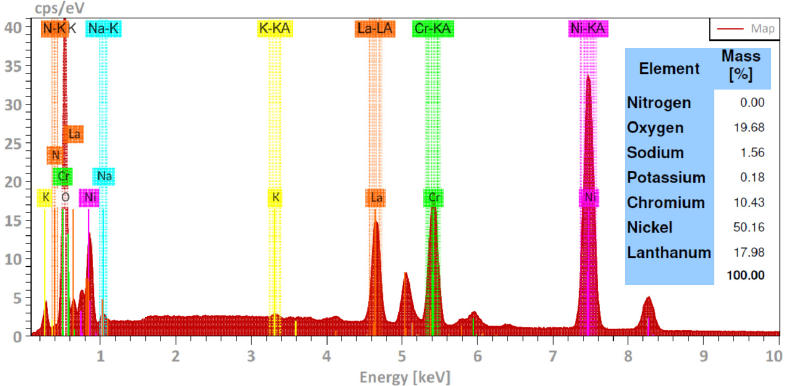
Figure 7. Elemental chemical composition of the Ni20Cr alloy surface exposed in the ternary salt at 500 °C and 1000 h of immersion.